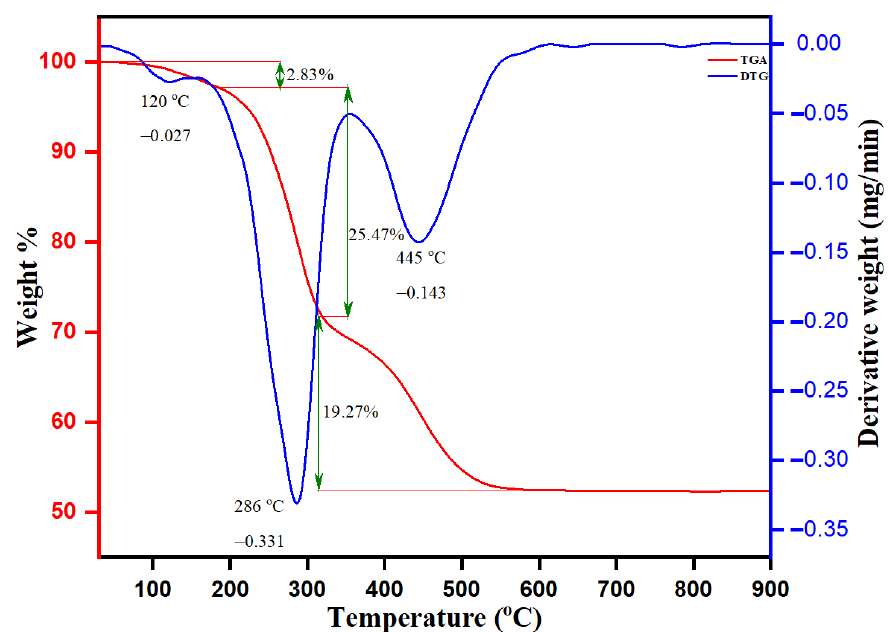
Figure 8. TGA-DTG analysis curve of ZnO NPs.